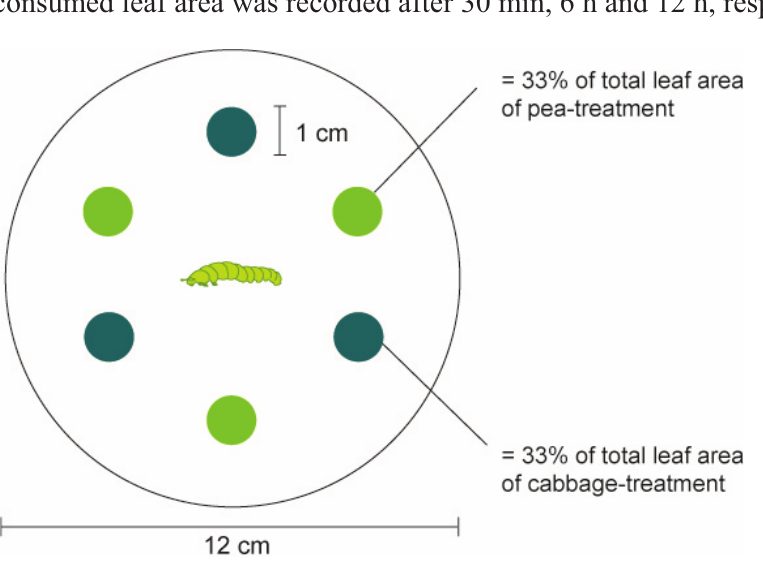
Figure 1. Experimental set-up of larval feeding choice assay. Pea and cabbage leaf discs were offered in an alternate order and a fourth-instar larva was placed in the middle of the Petri dish. The positions of larva were recorded after 5 min, 30 min, 6 h and 12 h, and percentage of consumed leaf area was recorded after 30 min, 6 h and 12 h,